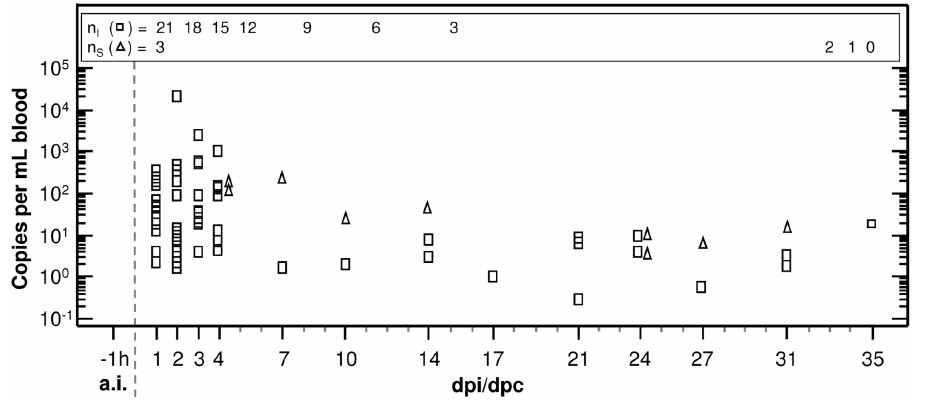
Figure 1. Detection of C.psittaci DNA in blood samples. The number of genomic equivalents to inclusion-forming units as determined by quantitative rtPCR was maximal within one week after both experimental challenge (squares) and natural acquisition (triangles). In experimentally challenged calves the maximal number of copies per mL blood varied between different animals to a large extent. Medians of three extractions, each run in duplicate were calculated for each blood sample. Mann-Whitney rank sum test was conducted to compare the amount of chlamydial DNA at different time points within the group of experimentally inoculated calves. Significant P -values are given in Table 1. a.i. ante infectionem . dpi days post inoculation. dpc days post contact to inoculated calves. h hour. n I number of inoculated calves. n S number of sentinels.